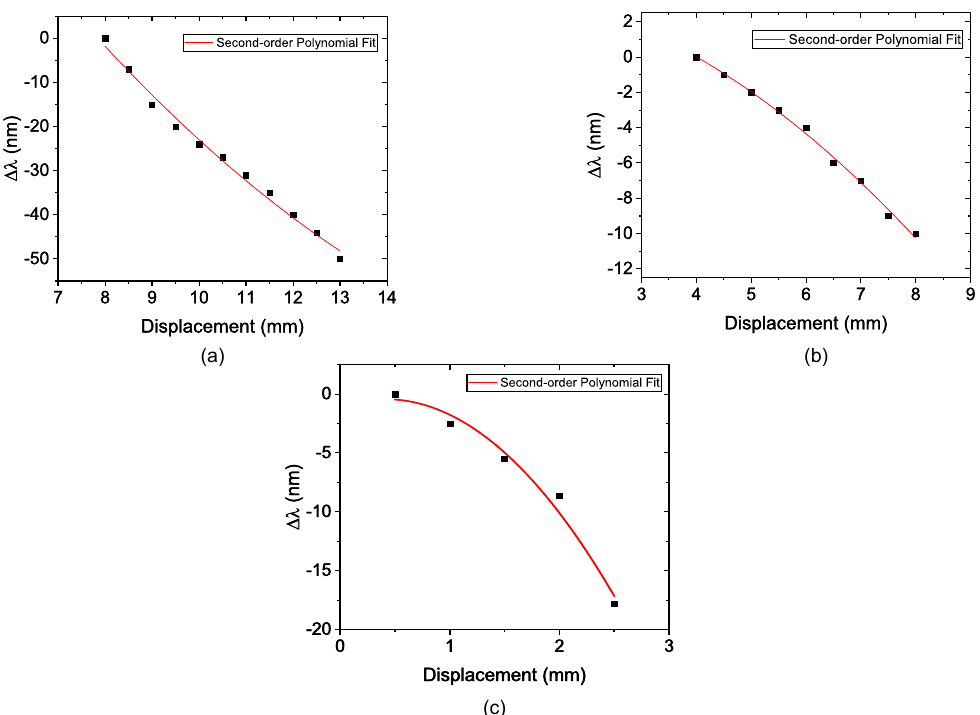
Figure 9. Wavelength shift as a function of displacement with D S = 80 mm and ( a ) the sensor with FP = 5 mm; ( b ) the sensor with FP = 10 mm; ( c ) the sensor with FP = 15